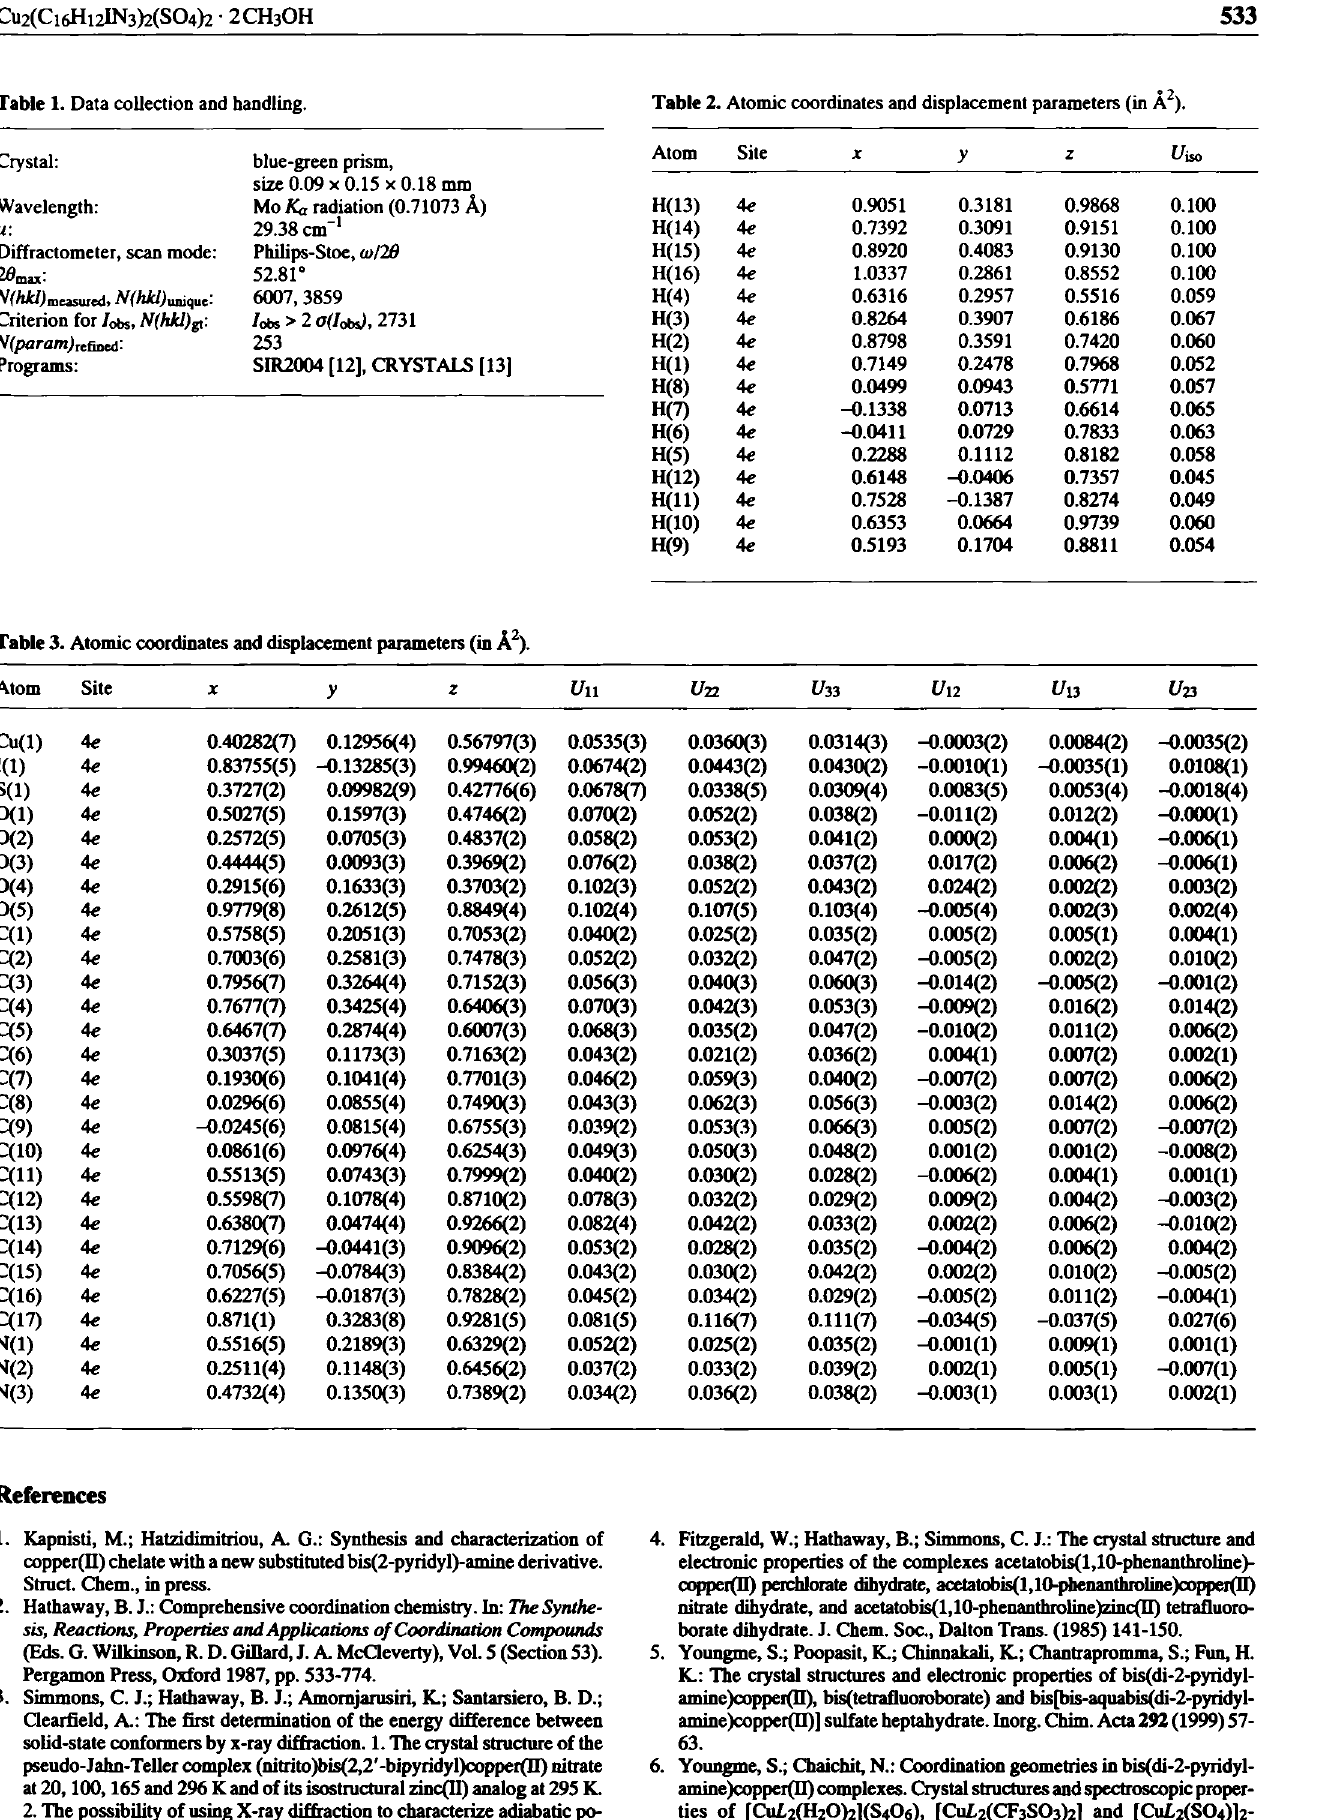
Table 1. Data collection and handling. Table 2. Atomic coordinates and displacement parameters (in Ä 2 ).